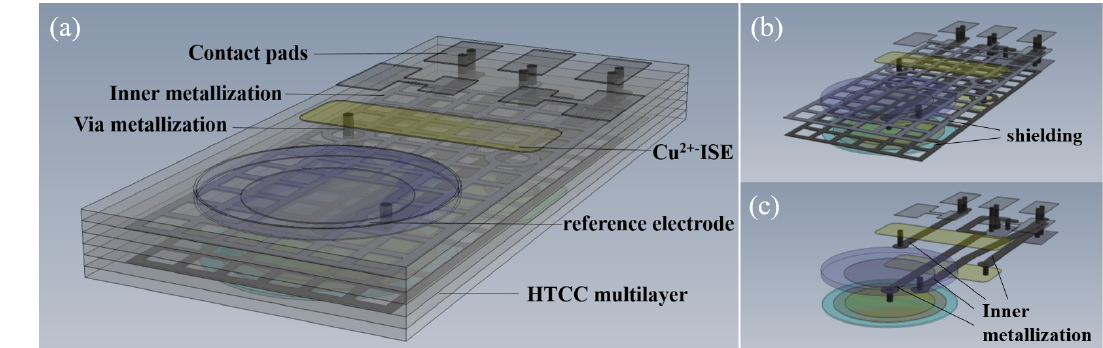
Figure 2. The HTCC-based sensor array (CAD drawing): (a) bottom view with reference electrode and ion-selective electrode, e.g. copper ion, (b) shielding against electromagnetic fields, and (c) inner metallization for potential derivation.